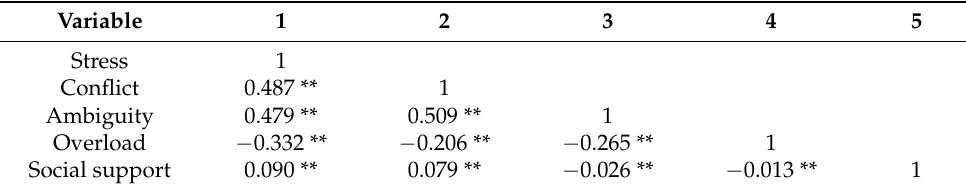
Table 2. Pearson Correlation between stress and the study variables.